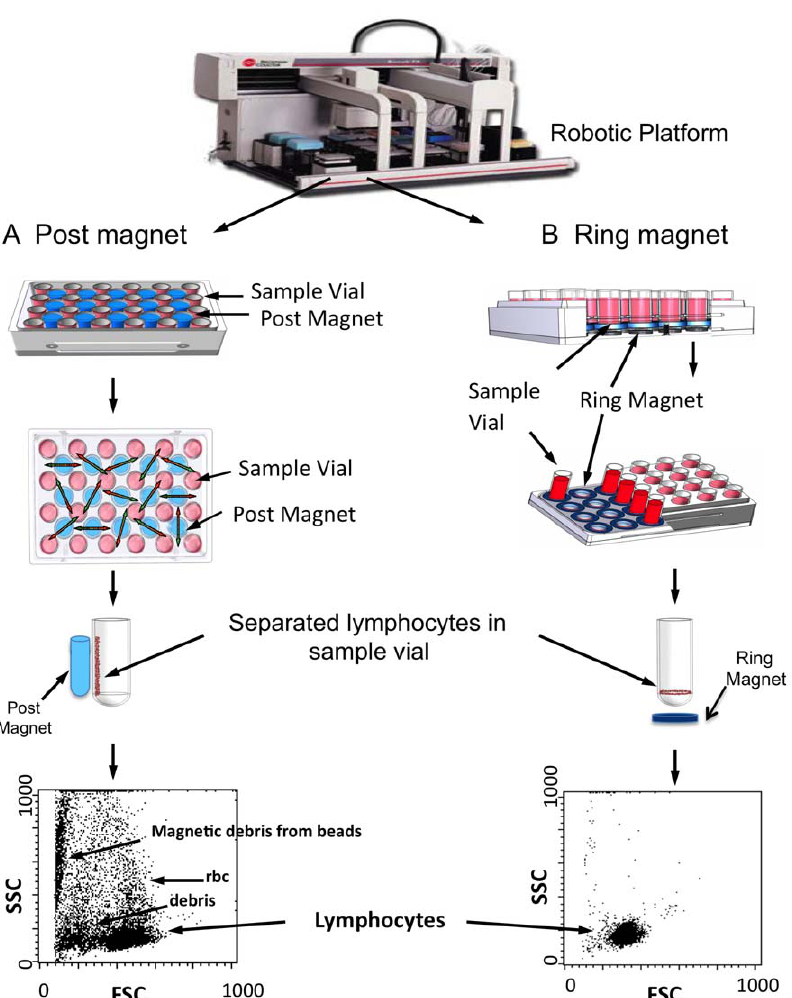
Figure 2. Automated magnetic separations of lymphocytes from human blood using a robotic platform. We compared two different plate designs for the robotic platform (A,B). For each test system, Nunc vials were loaded with fresh human blood and paramagnetic beads tagged with the antibody to the whole blood cells of interest was added to the sterile vials. This blood and antibody mixture typically was tested for its ability to separate lymphocyte subsets, such as CD8 or CD4 white blood cells. The most robust platform design gradually culminated in two different plate designs with varying configurations of the external magnets. On the left (A) is a plate design with a post magnet on the outside of the Nunc vial. On the right (B) is a plate design with a ring magnet design at the base of the Nunc vial. The resulting separated lymphocytes were evaluated for the highest yield, viability and purity. It was first thought that a full-length magnet along the side of the tube would facilitate the cellular separations. However, the disadvantage of this plate design was that every magnet experienced interference from the surrounding magnets, thus decreasing the overall density of Nunc vials for maximal efficiency and/or decreasing the magnetic force. As a result, this method produced lymphocyte preparations contaminated with RBCs and magnetic debris, as shown in the left scatter plot of the yielded cells. In contrast, the ring magnets in (B) produced internally consistent magnetic fields that did not interfere with adjacent ring magnets since the pulling force was exclusively directed to the interior of the vial. Also, the ring magnet configuration maximizes the plate capacity for the maximal number of Nunc vials per plate, and allowed the isolation of CD8 lymphocytes from whole blood with much higher purity (right scatter plot). doi:10.1371/journal.pone.0022430.g002 isolation method on the detection of lymphocyte subpopulations was the more highly sensitive ‘‘tetramer’’ method. This highly